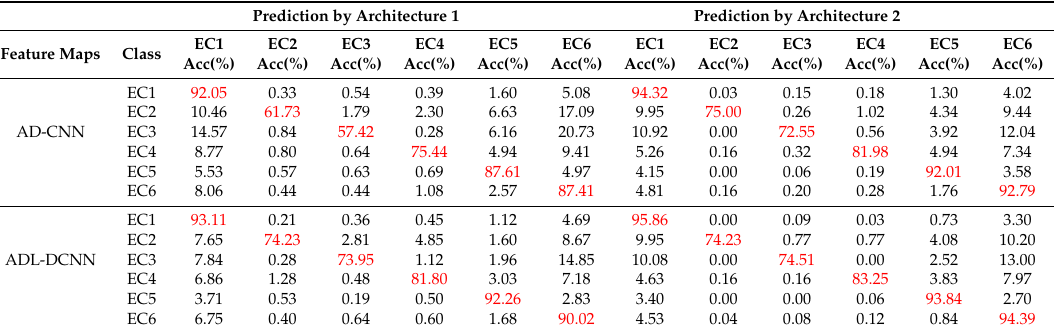
Table 2. Matrices for each fusion scheme and feature maps Prediction by Architecture 1 Prediction by Architecture 2 Feature Maps